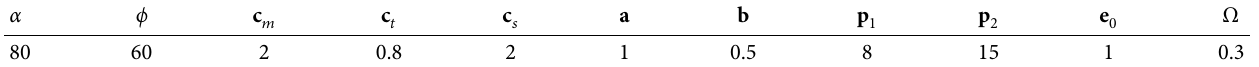
Table 2: The value of the